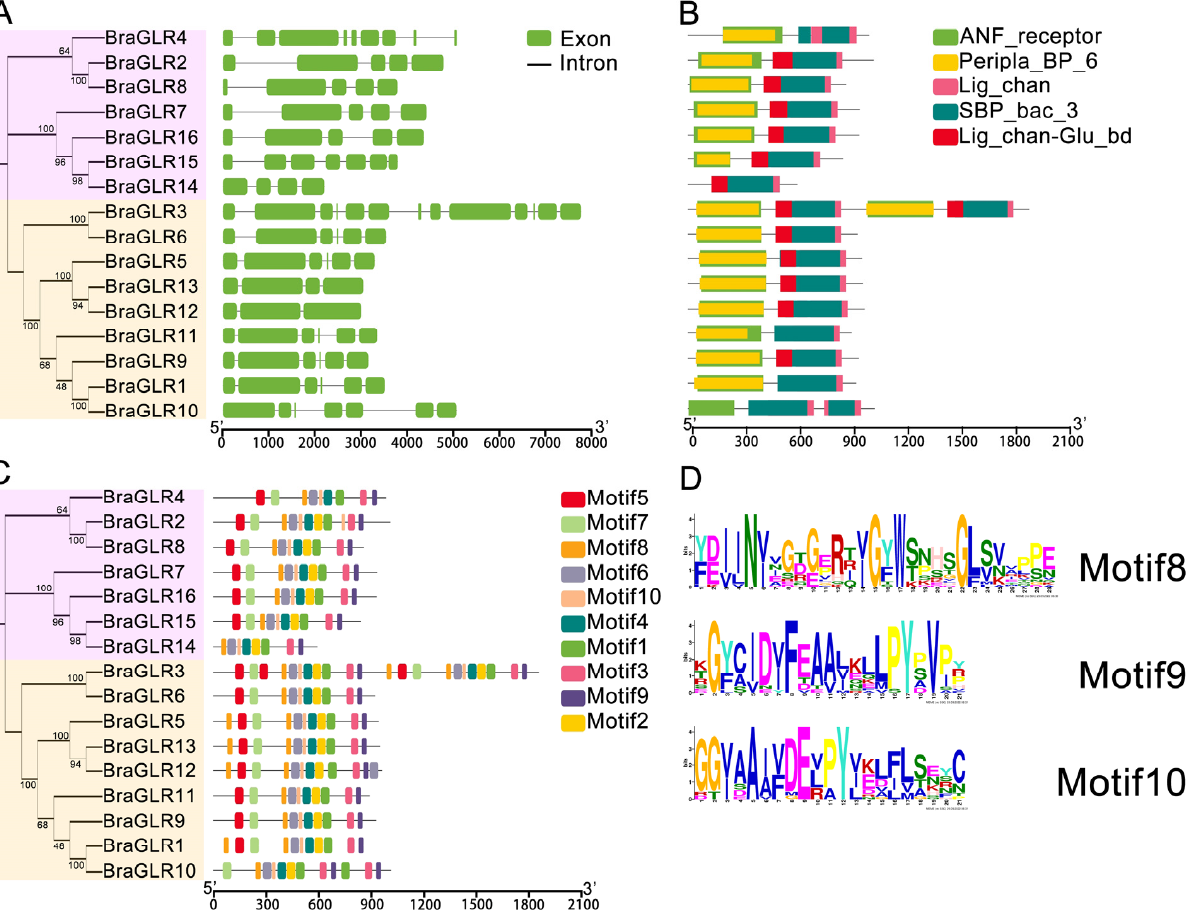
Figure 2. Structure and conserved domain analysis of GLRs in B. rapa . ( A ) Gene structure of the GLR genes in B. rapa . The exons and introns are represented by green boxes and black lines, respectively. ( B ) Analysis of the functional structural domain of GLR genes in B. rapa . ( C ) Analysis of the conserved structural domain of GLR genes in B. rapa . ( D ) Motif sequence. See Figure S1 for detailed motif